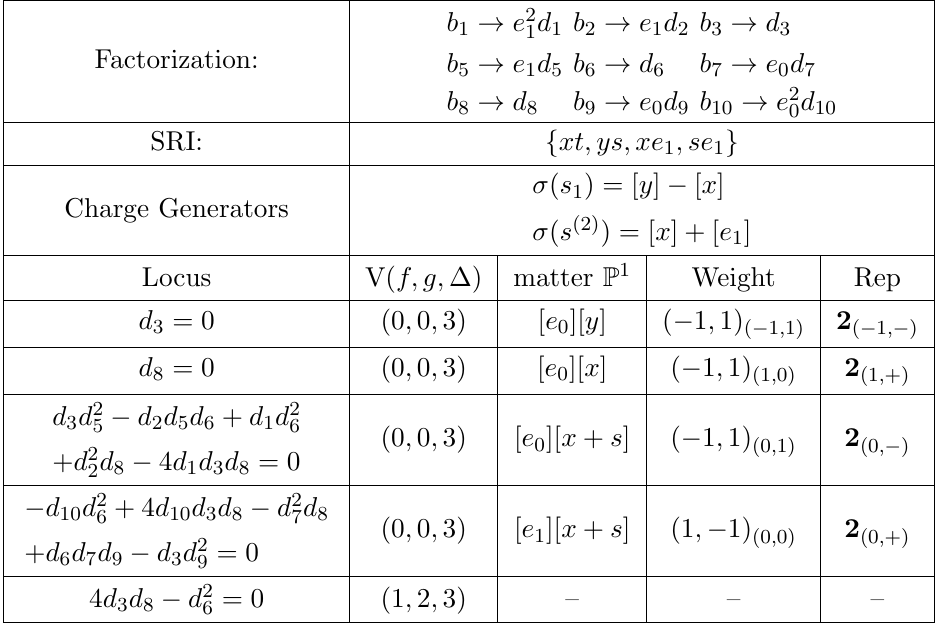
Table 14 . Summary of SU(2) top